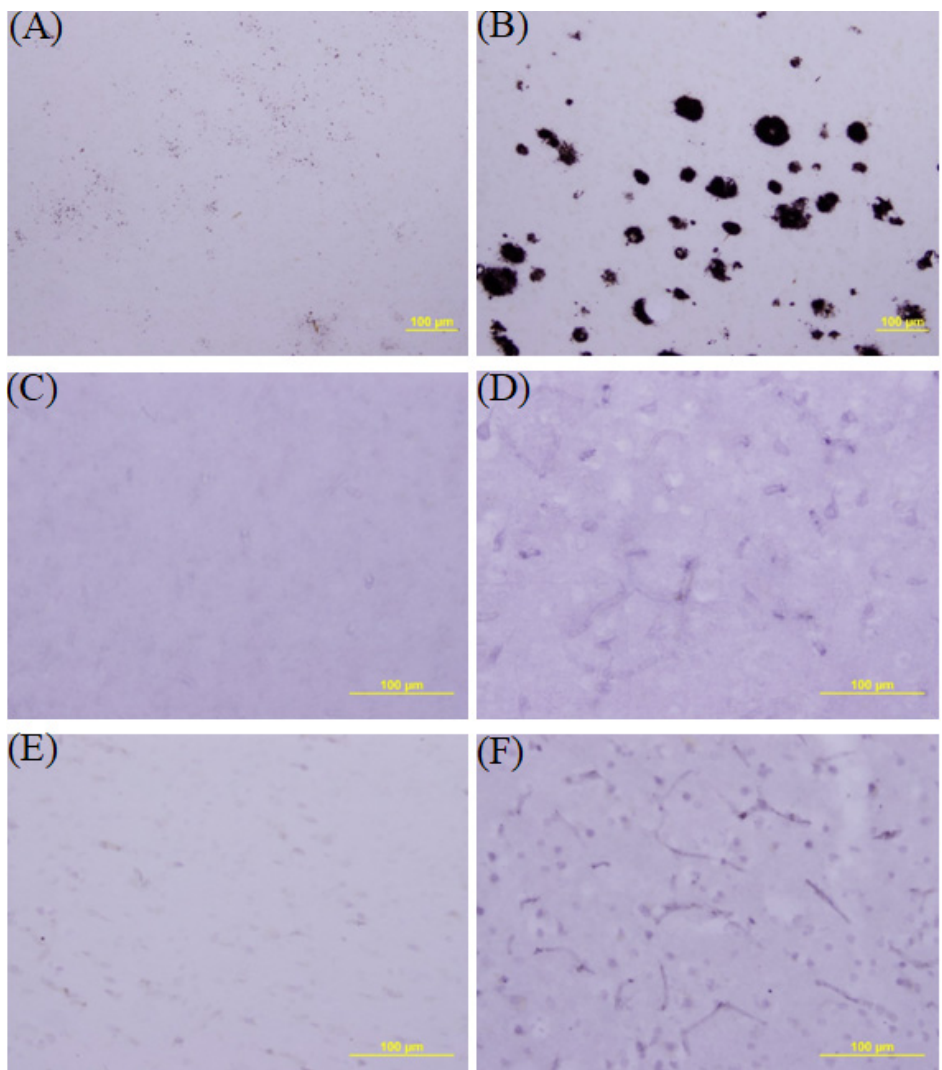
Figure 1. Abeta42 immunostaining of the hippocampal area of brain tissue from a healthy case ( A ) and from a patient dying with Alzheimer’s disease(AD) ( B ). Abeta 42 accumulation was found in the AD brain. C-reactive protein (CRP) immunohistochemical data of hearts from a healthy control case ( C ) and from a patient dying with coronary heart attack ( D ). CRP expression was increased in the coronary heart attack case compared with the healthy case. Immunohistochemical staining oftumornecrosis factor(TNF) in brain tissue from a healthy case ( E ), and a cancer case ( F ). Notice the intense immunostaining of capillaries in the cancer case compared to the normal